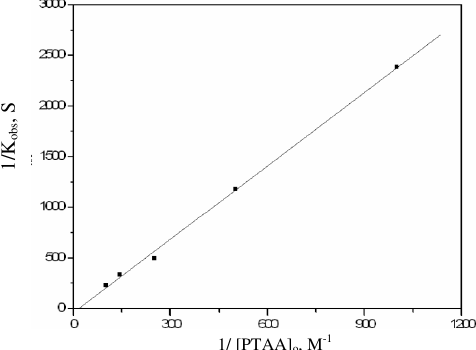
Figure 1. Double reciprocal plot for the oxidation of PTAA with NBP